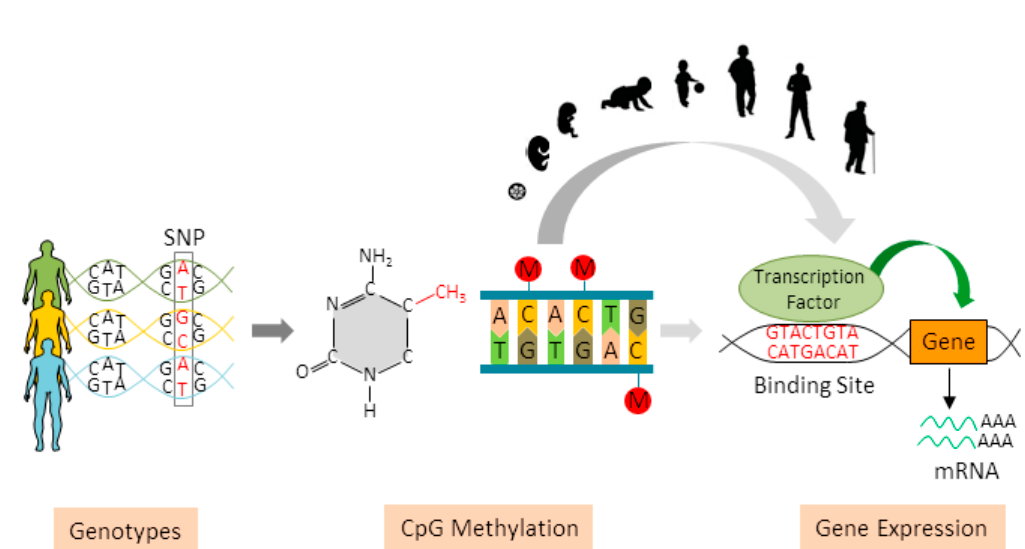
Figure 1. Role of methylation quantitative trait loci (meQTLs) for gene expression. Genetic variation influences levels of DNA methylation at regulatory regions and can modulate gene expression leading to decreased or increased gene transcription. Importantly, the effects of genetically induced changes in DNA methylation critically depend on developmental stage, and possibly, environmental context. SNP: single nucleotide polymorphism.